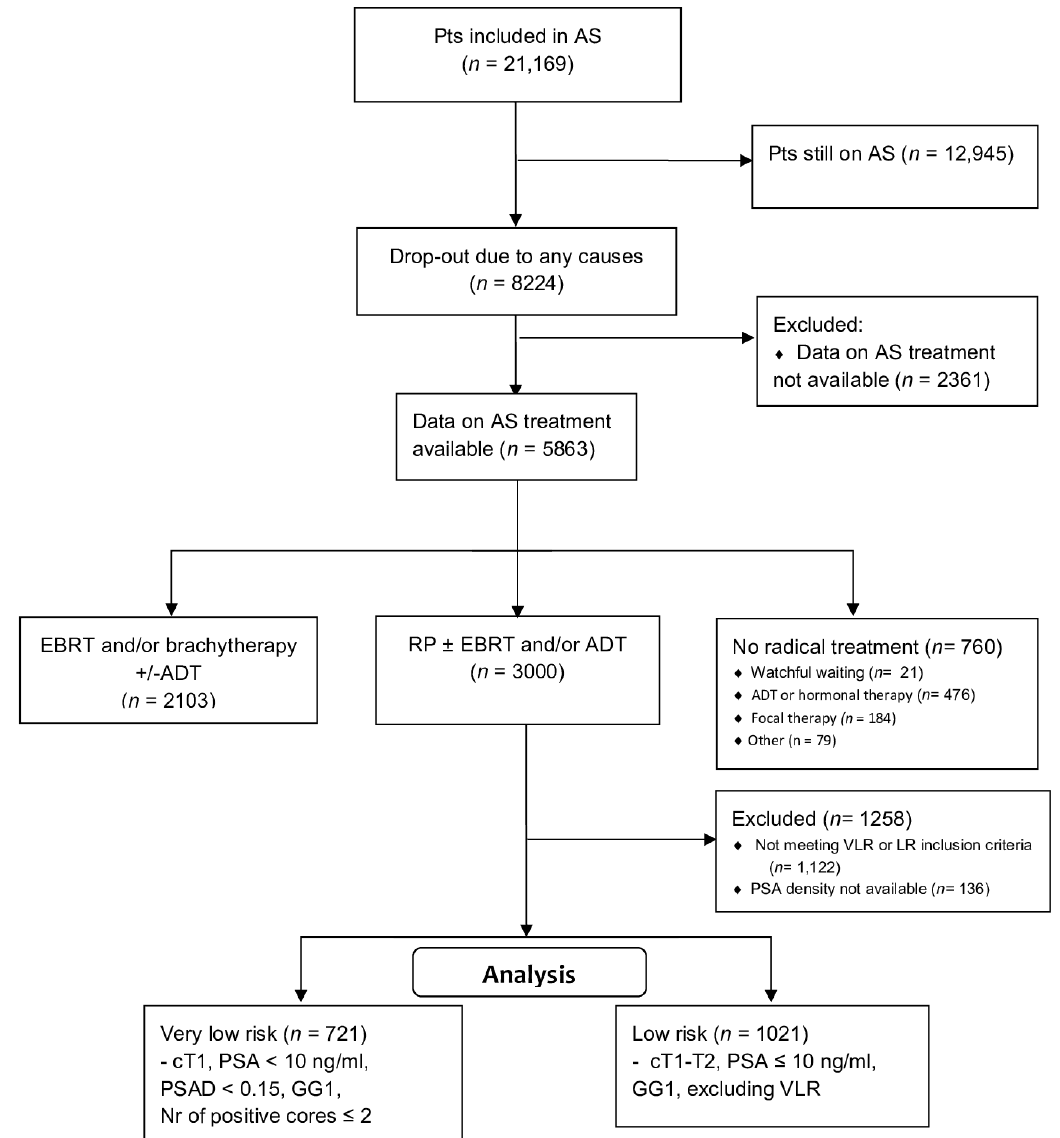
Figure 1. CONSORT flow diagram showing the selection process of the study population from the whole GAP3 AS